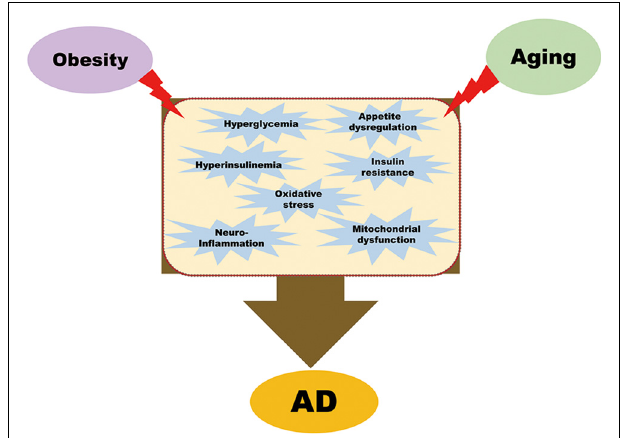
FIGURE 1 | Common pathological mechanisms that link obesity with Alzheimer’s disease (AD). Obesity leads to hyperglycemia, hyperinsulinemia, insulin resistance, oxidative stress, appetite dysregulation, neuroinflammation, and mitochondrial dysfunction. All these pathological conditions, combined with aging, are contributory factors of